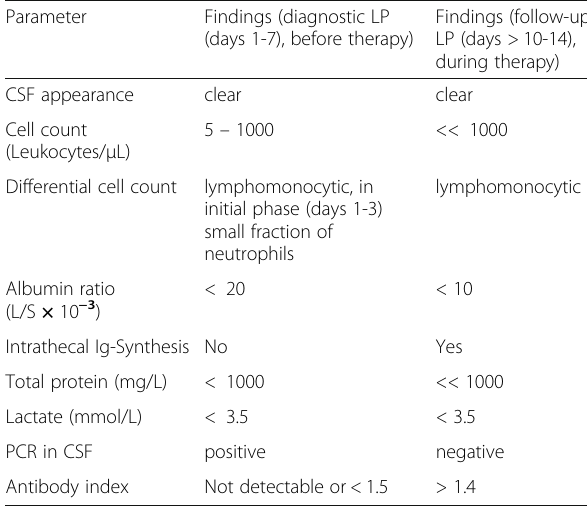
Table 9 Typical CSF findings in acute and subacute phases of viral CNS infections